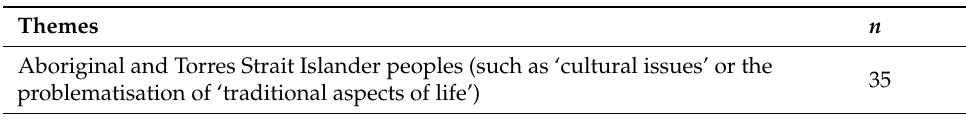
Table 2. Emerging themes as the attributed reason for inequity in the learning objectives (n = 91), thematically